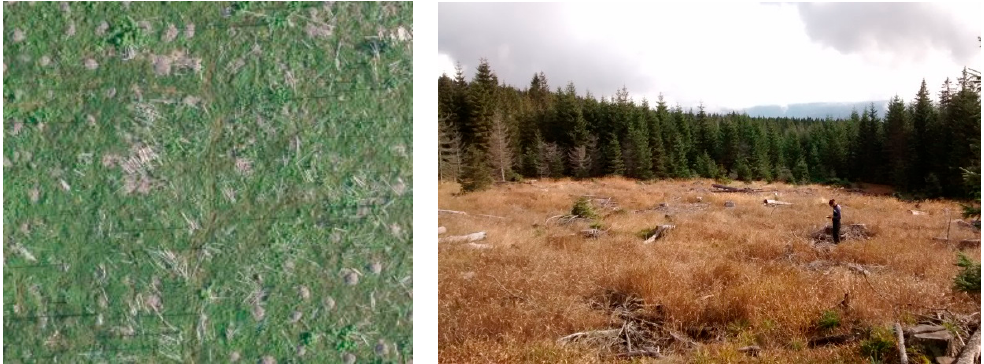
Figure A6. Aerial photo and photo of class C1.